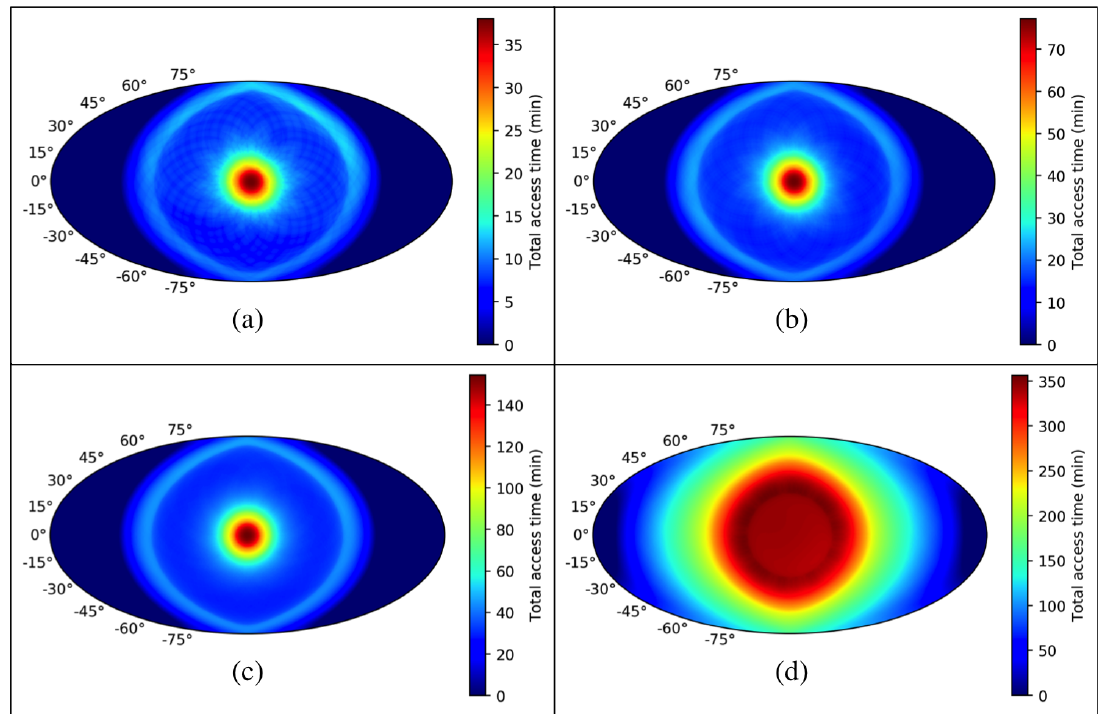
Figure 12. Total access time according to the position of L2-CalSat relative to the CMB satellite for a FoV of 30 ◦ and throughout 6 ( a ), 12 ( b ) and 24 h ( c ), and for a FoV of 120 ◦ and throughout 12 h ( d